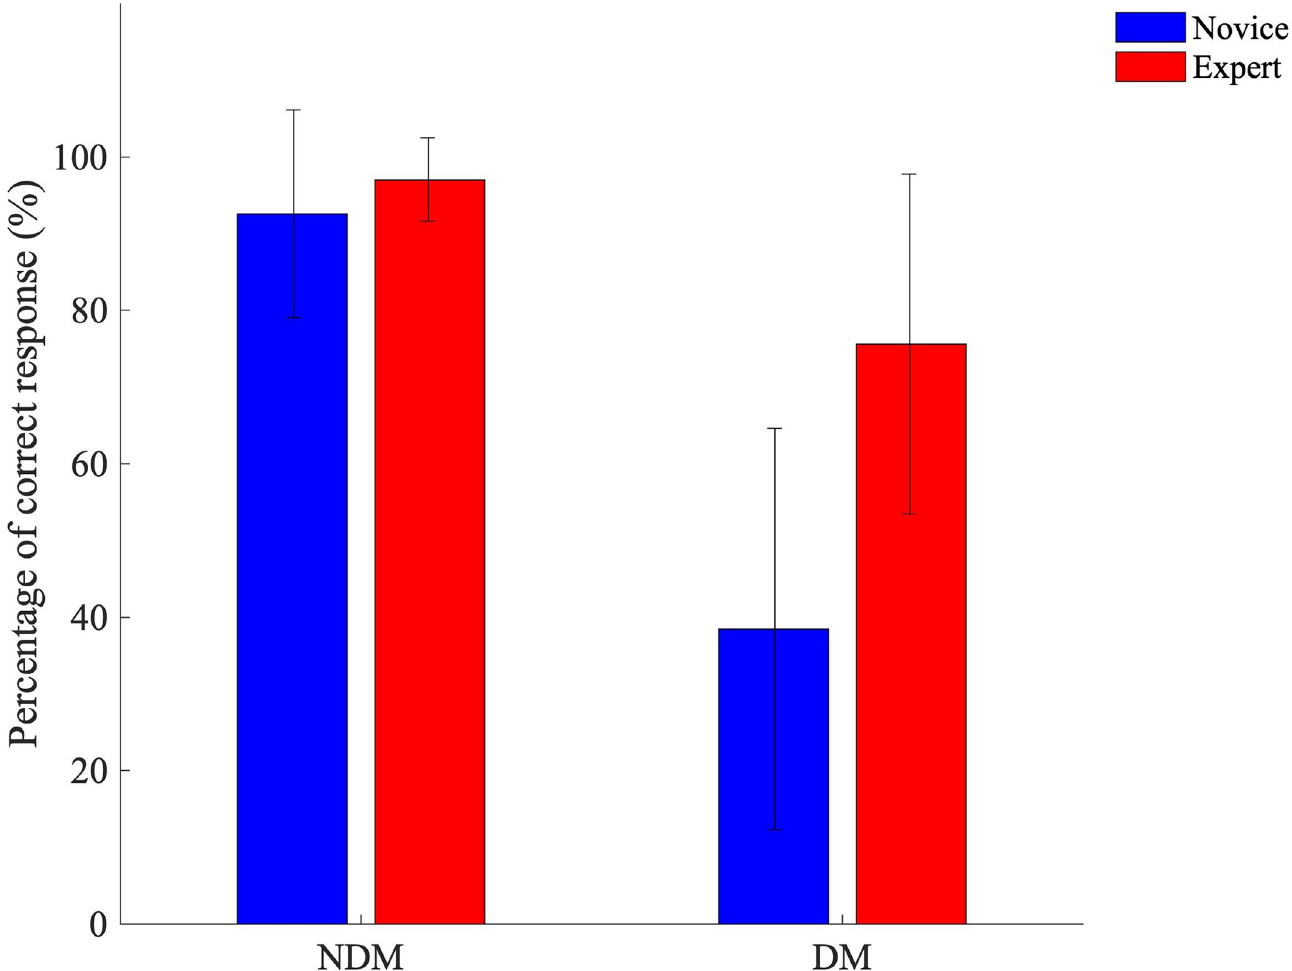
Fig 5. Interaction effects during the perception-action task. Mean ± SD percentage of success when considering effects observed for interactions during the perception-action task between level and